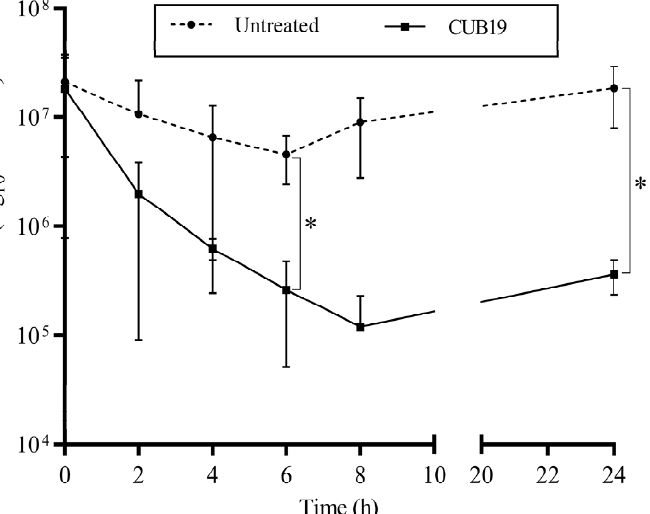
Figure 5. Time-kill curve. S. maltophilia biofilm treated with CUB19 (10 8 PFU/mL) and untreated monitored at 2 h intervals for the first 8 h and after 24 h. Data are expressed as mean ± standard deviation. Results were statistically analyzed using an unpaired t test with Welch’s correction analysis integrated in GraphPad Prism 6; p -values <0.05 were considered significant (*).